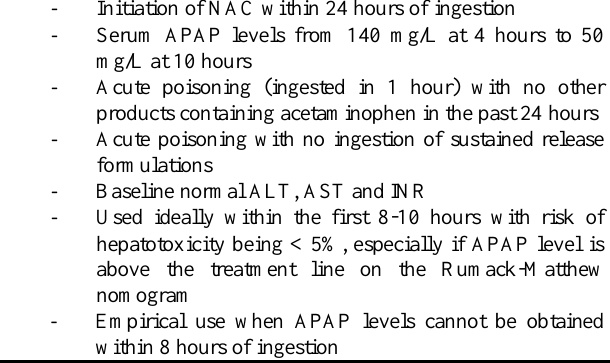
3: Clinical indications for NAC use. APAP: